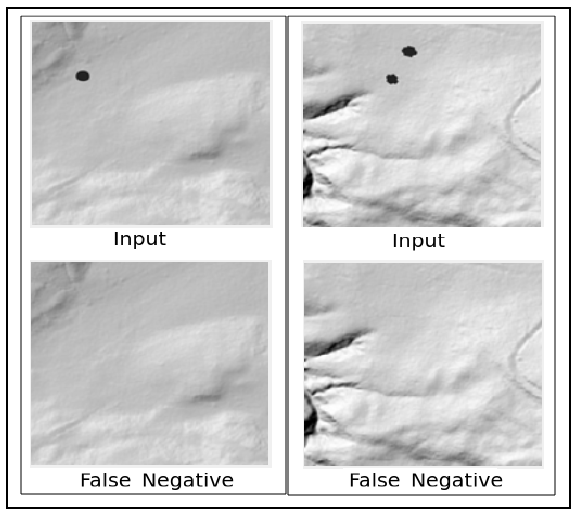
Figure 7. Examples of false negatives produced by the 2D- CNN model. The black dots show the archaeological sites that were not